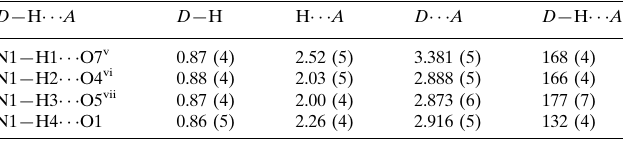
Hydrogen-bond geometry (A˚ , (cid:3)